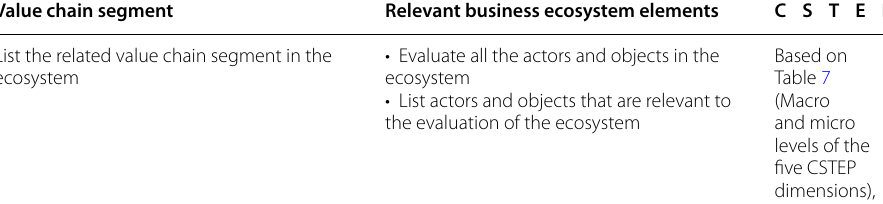
Table 12 Investigation of related CSTEP dimensions for business ecosystem elements